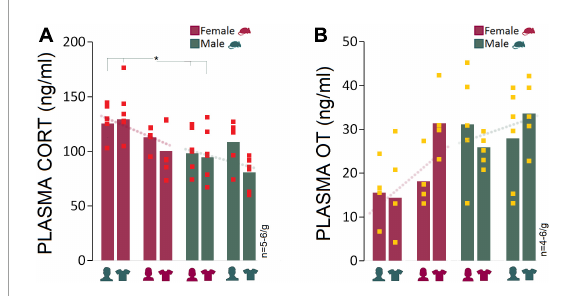
FIGURE5 Corticosterone and oxytocin responses to stress and experimenter sex. (A) Average CORT levels in females across all experiments were higher than males. Exposure to an opposite-sex experimenter significantly elevated plasma CORT levels in female rats only. There were no significant differences between females and males in Experiments 3 and 4 when exposed to same-sex experimenters or their T-shirts. Red squares represent individual animals in each group. Gray boxes represent statistically significant differences between sexes (* p ≤ 0.05, Mann–Whitney U ; n = 5–6/group). (B) Female rats responded to the presence of a male experimenter with reduced plasma OT levels. In contrast, male rats experienced marginal changes in plasma OT levels across experiments ( n =